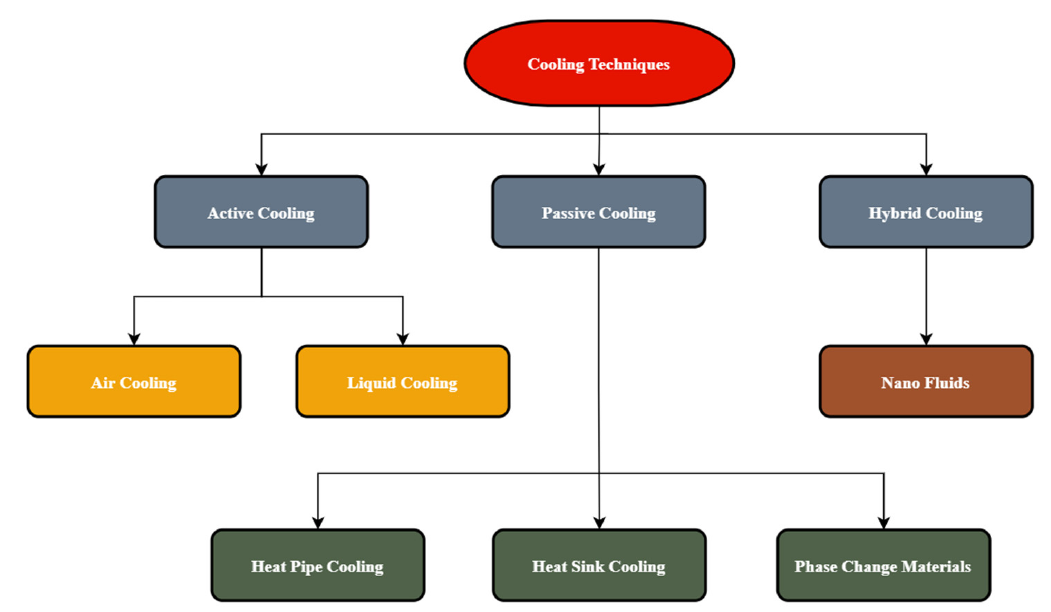
Figure 44. Flowchart diagram of cooling techniques.